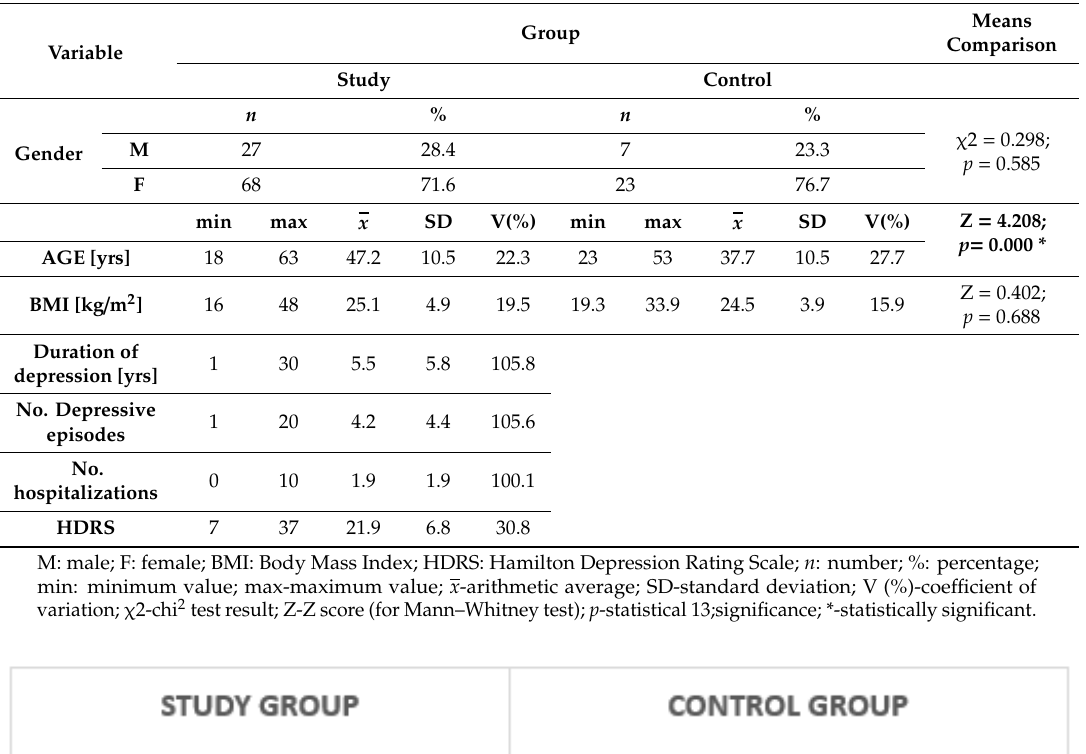
Table 1. The demographic and baseline characteristics.